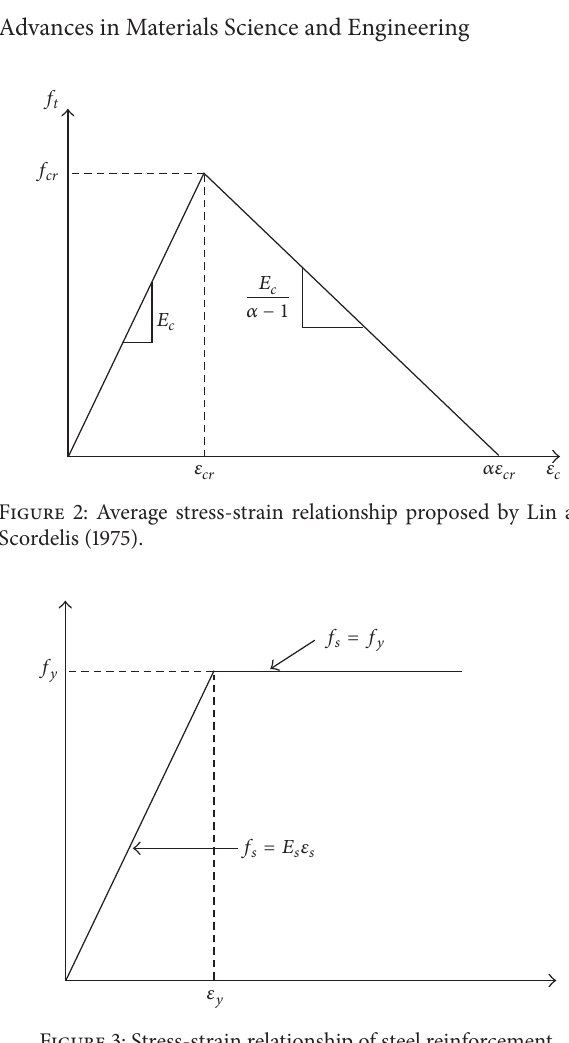
Figure 3: Stress-strain relationship of steel reinforcement.